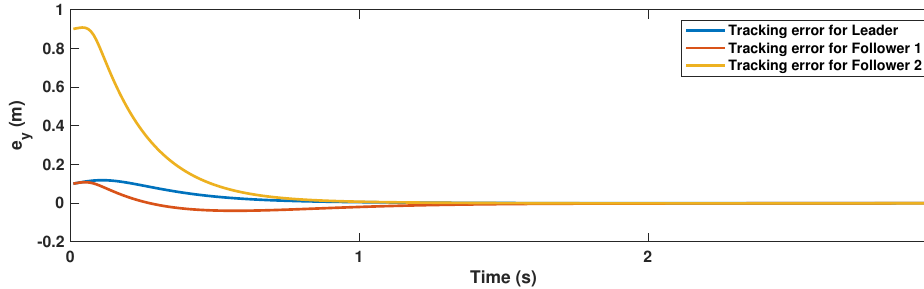
Figure 11. Path 2: The tracking error on the Y-axis.